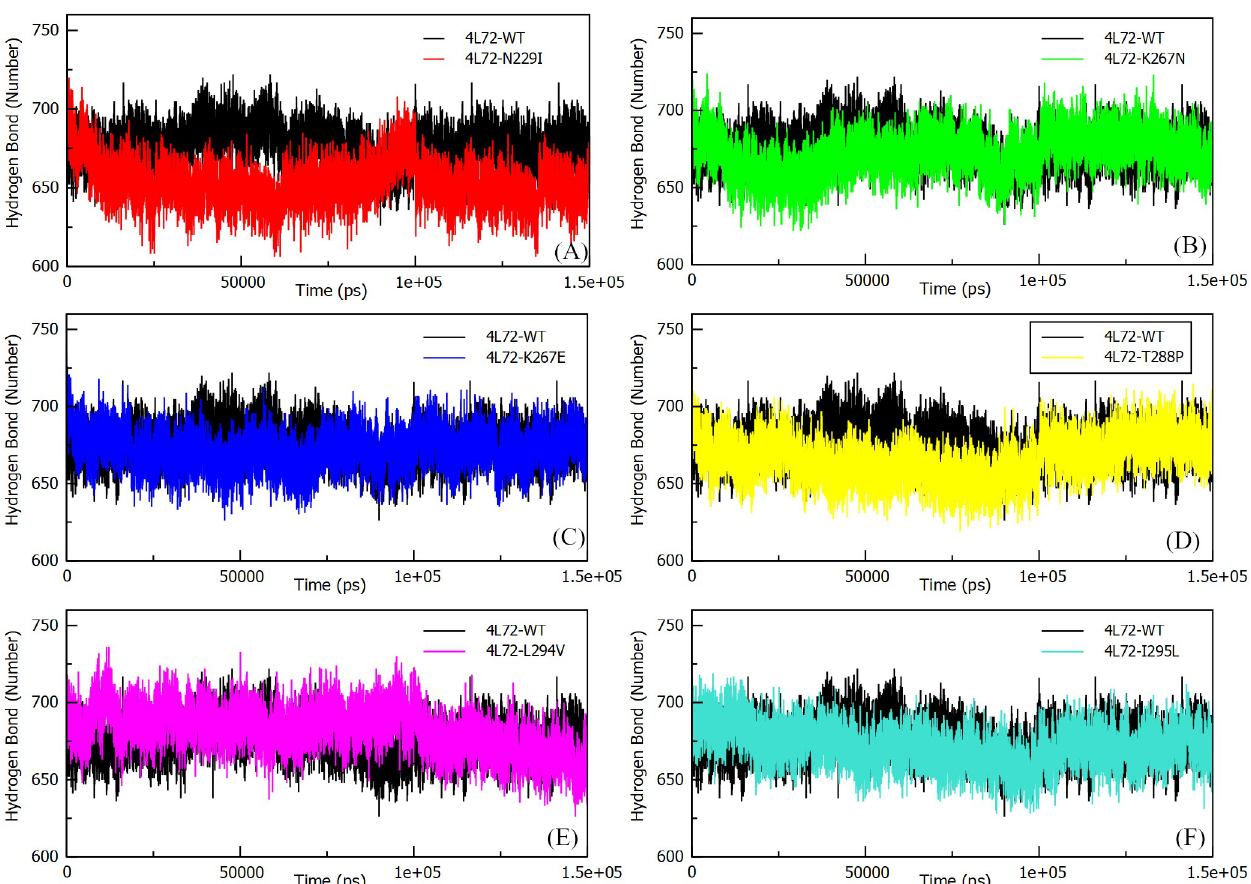
Fig 6. Total number of hydrogen bonds interactions between MERS-CoV S1 RBD protein and human DPP4 wild and mutant types during 150 ns of the molecular dynamics simulation period. (a) H-bond 4L72-WT vs 4L72-N229I. (b) H-bond 4L72-WT vs 4L72-K267N. (c) H-bond 4L72-WT vs 4L72-K267E. (d) H-bond 4L72-WT vs 4L72-T288P. (e) H-bond 4L72-WT vs 4L72-L294V. (f) H-bond 4L72-WT vs 4L72-I295L.